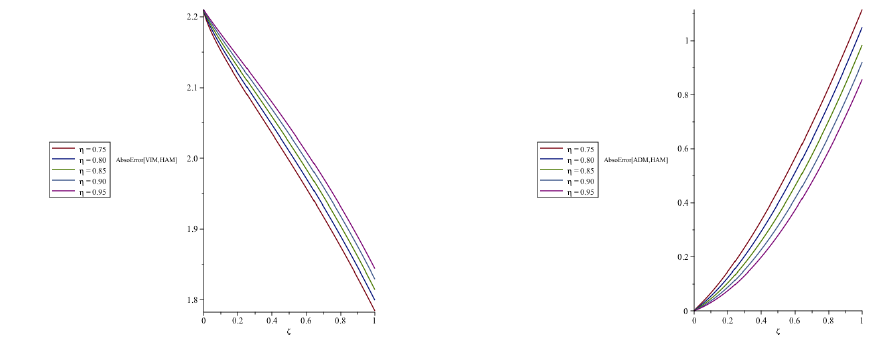
Figure 5. Plot of the second-level approximate solution ψ 2 ( χ , ζ ) at χ = 0.1 for different values of η when ¯ h = − 1 for Example 1.